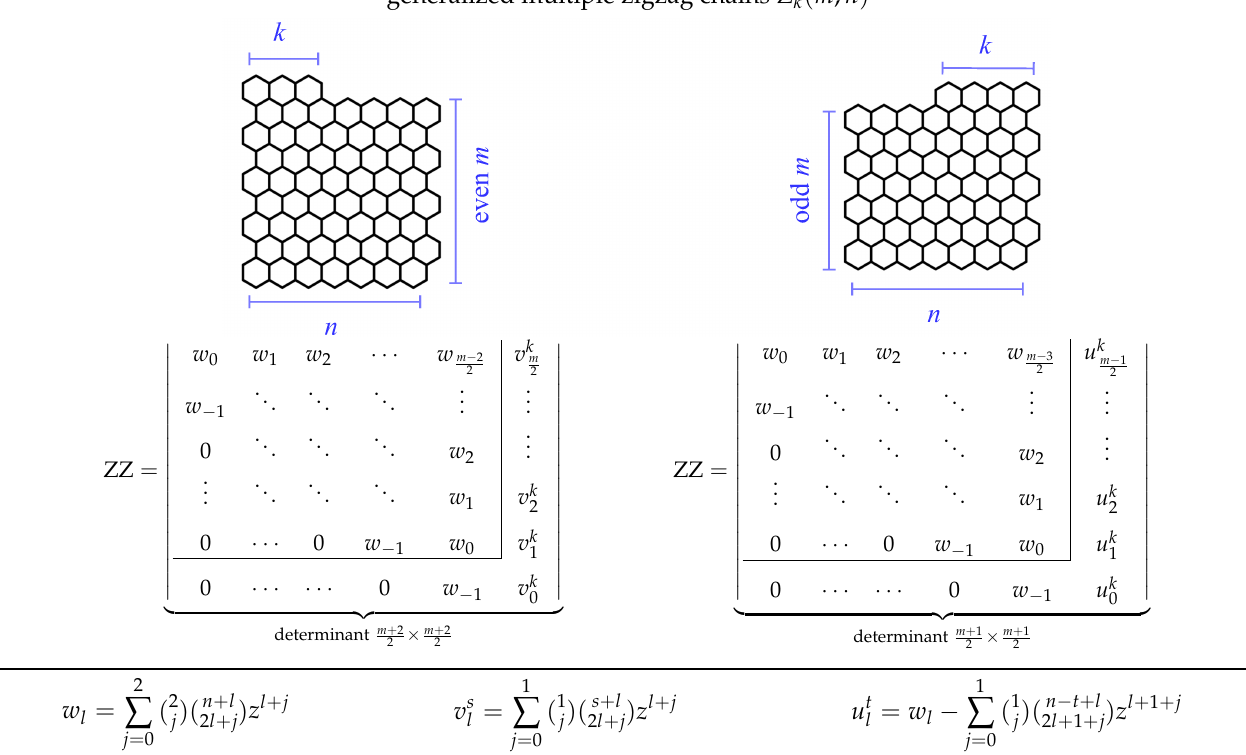
generalized multiple zigzag chains Z k ( m , n )